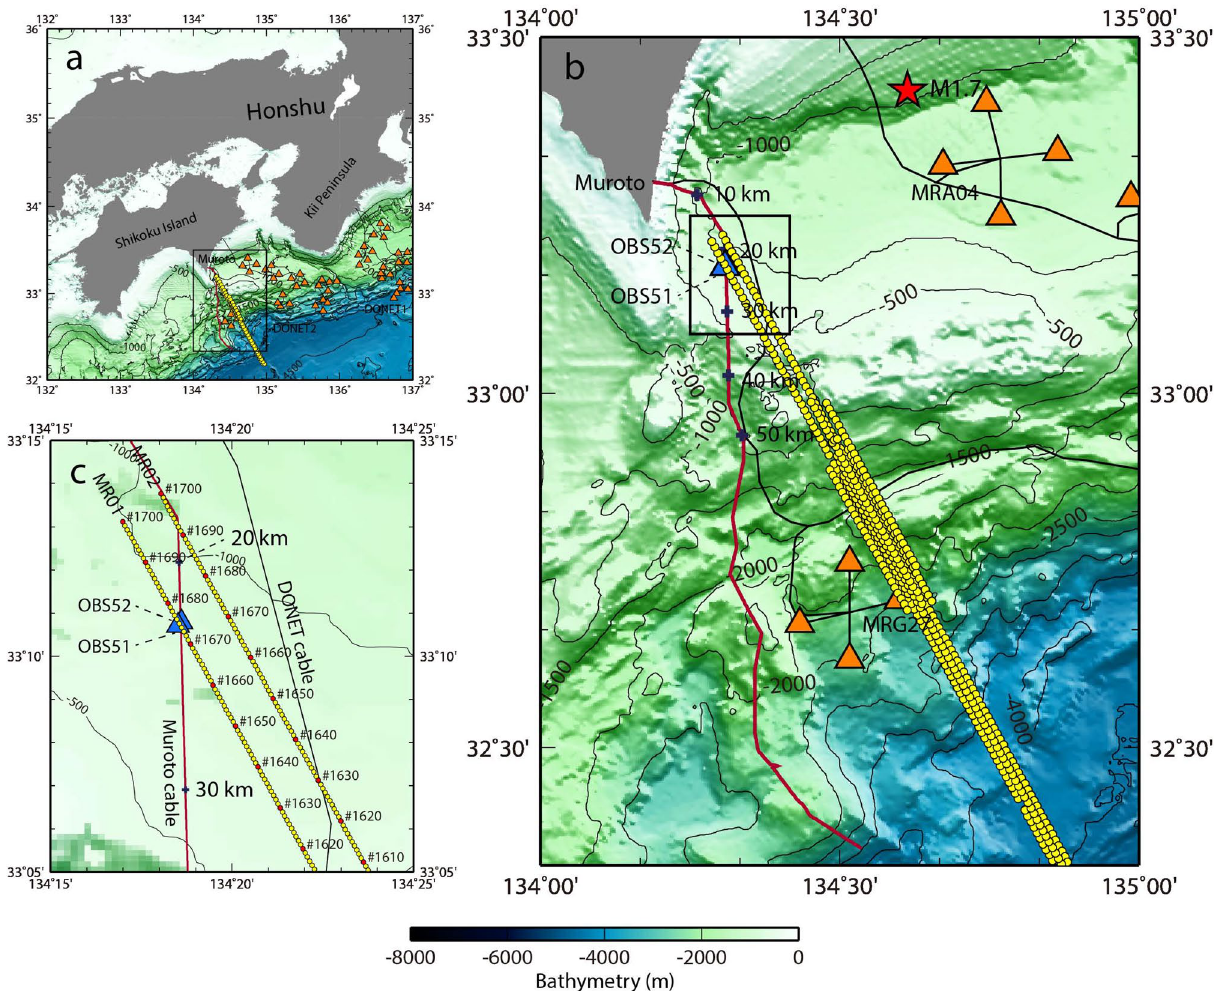
are shown. ( a ) The DAS experimental site is located off Shikoku Island, Japan, where the DONET observatories are deployed. ( b ) Detailed map of the Muroto cable and the surrounding area. The Muroto cable is 128 km long of which the cable section up to 50 km is used for the DAS measurement. Cable length is indicated by a blue cross at every 10 km. Two OBSs, i.e. OBS51 and OBS52, had been deployed near the Muroto cable temporally during the air-gun shots. The seismic survey lines with the air-gun shots were located over the Muroto cable and one DONET observatory, MRG27. ( c ) Detailed map of the air-gun shots near the Muroto cable. The